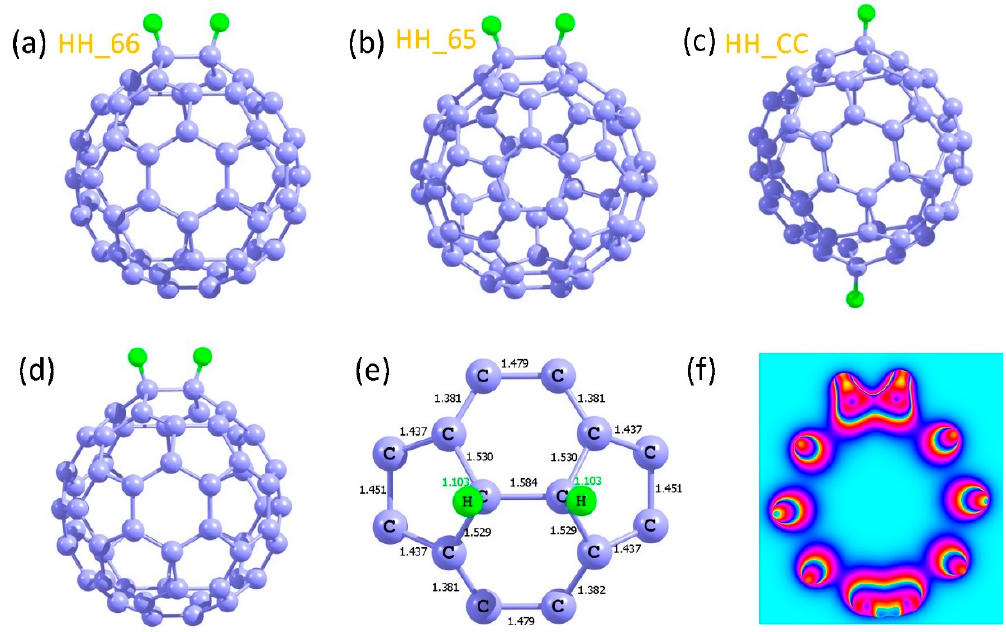
Figure 3. ( a – c ) Three different initial configurations considered for the adsorption of two hydrogen atoms, ( d ) relaxed structure of the most stable configuration (HH_66), ( e ) bond distances near the adsorbed atoms and ( f ) charge density plot associated with the interaction of hydrogen atoms with carbon atoms on the surface.